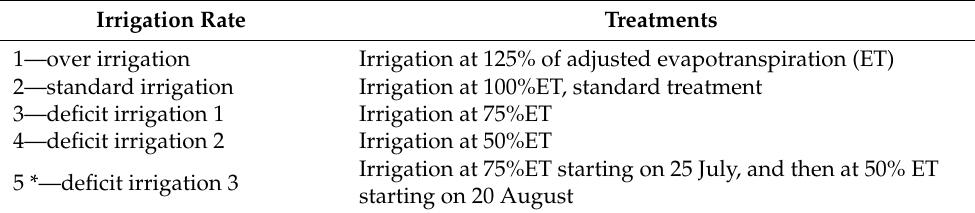
Table 1. Irrigation treatments that were applied in this